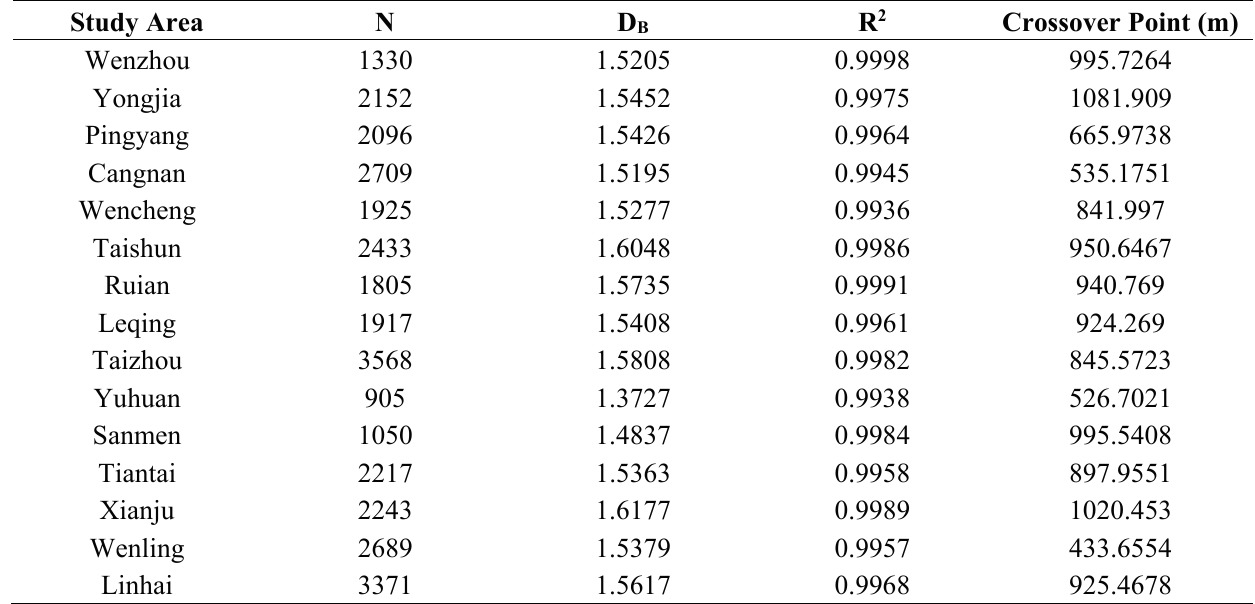
Table 1. Fractal dimension values of each city across the Wen-Tai region, China.